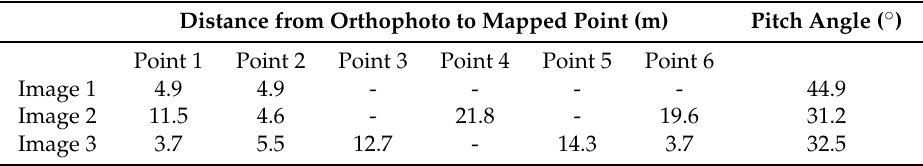
Table 7. Distance between mapped points and reference position in the orthophotograph for the three shown images.